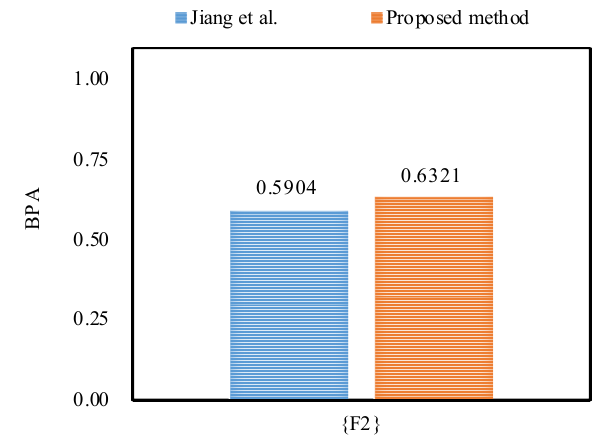
Figure 7. The comparison of the BPA of the target F 2 at 3 X